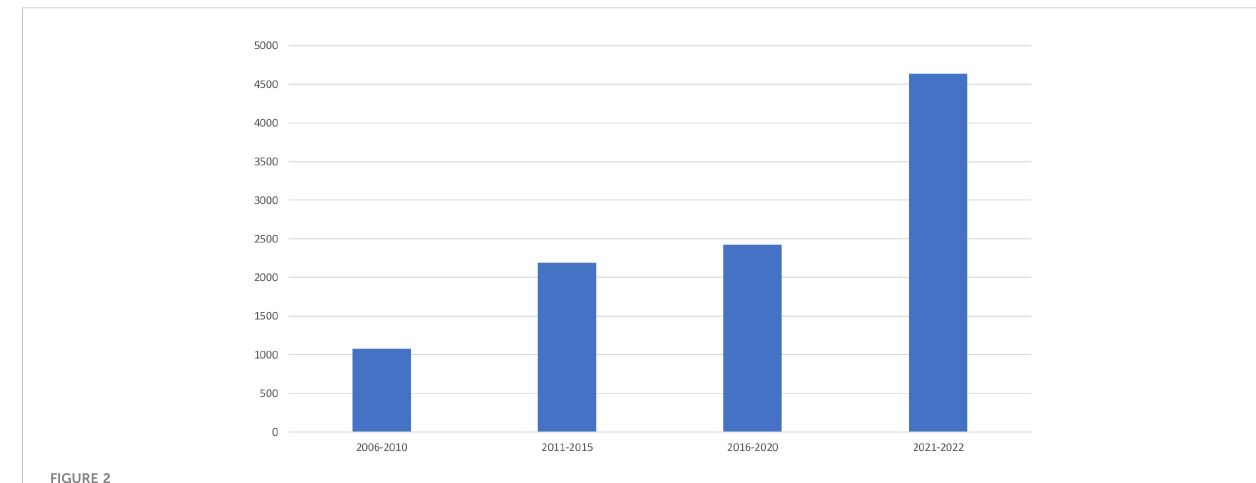
FIGURE 2 Total number of children with diabetes in Tanzania.